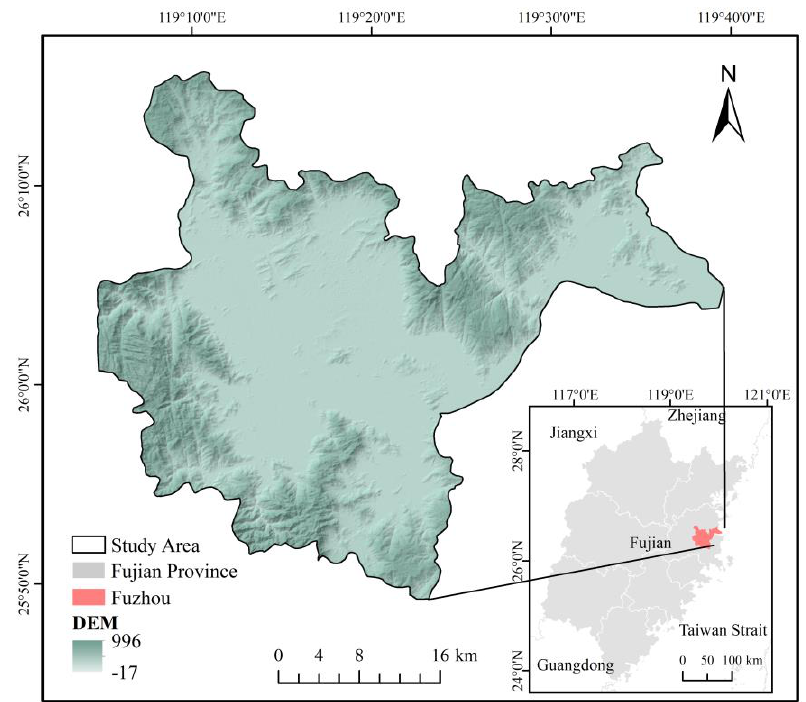
Figure 1. Location map of the study area.